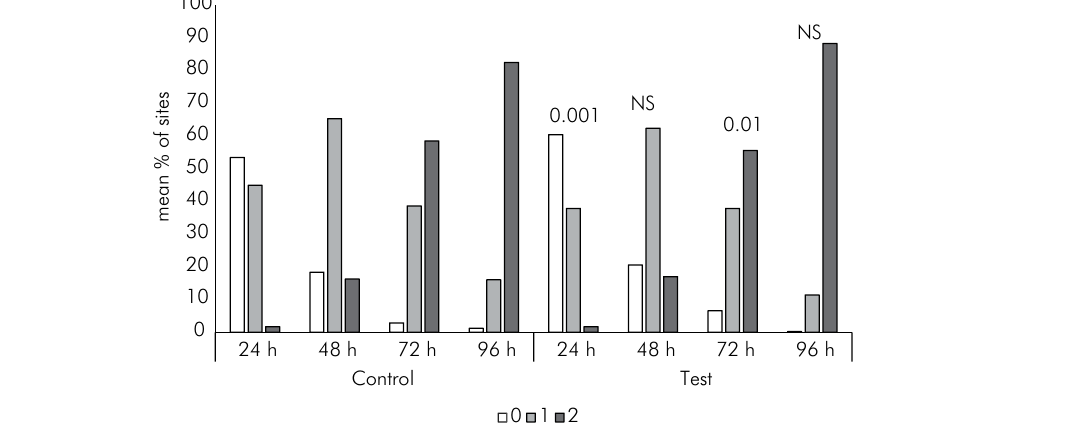
Figure 3. Mean percentage of scores 0, 1 and 2 in relation to proximal surfaces in each experimental period.